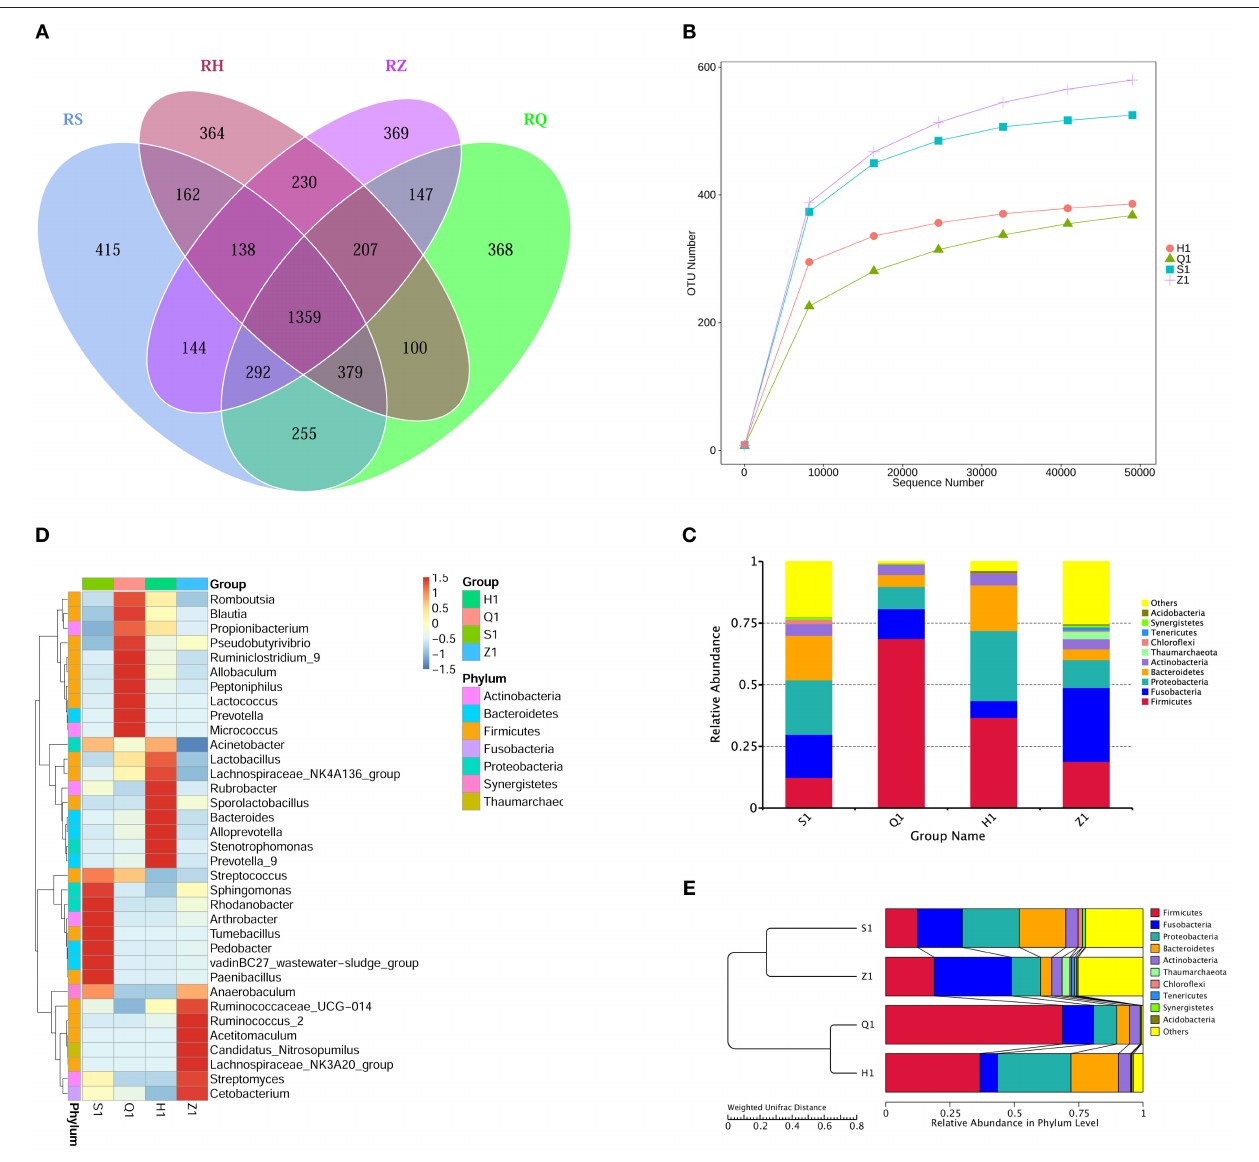
FIGURE 2 | The intestinal flora in different segments of tilapia were different in structure and diversity. (A) Venn diagram (Petals figure) illustrating the Common or characteristic OTUs in duodenum (S), foregut (Q), midgut (Z), hindgut (H). (B) Rarefaction curves of OTUs illustrating the microbial diversity in duodenum (S), foregut (Q), midgut (Z), hindgut (H). When the curve flattens, it shows that the amount of sequencing data is gradually reasonable, and more data will produce only a small number of new species (OTUs). (C) Column diagram illustrating the relative abundance of Intestinal flora at phylum level in duodenum (S), foregut (Q), midgut (Z), hindgut (H). The horizontal axis is the sample name, and the vertical axis represents the relative abundance of a classification. Different colors correspond to different species at the same level. (D) Heat maps illustrating the relative abundance of Intestinal flora at genus level in duodenum (S), foregut (Q), midgut (Z), hindgut (H). The color and intensity of each square represent the value of relative abundance. (E) UPGMA clustering tree illustrating the similarity between samples of duodenum (S), foregut (Q), midgut (Z), hindgut (H).